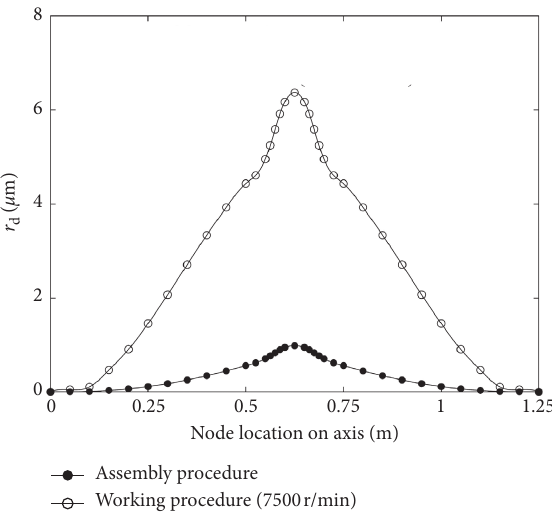
Figure 5: Rotor bending of imprecise bolt-disc rotor.